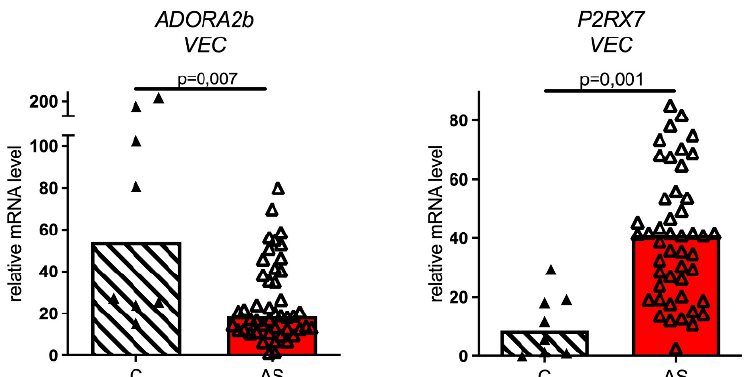
Figure 3. Expression levels of ADORA2b and P2RX7 in VEC. Relative mRNA levels in non-stenotic control cells (C) are compared with relative mRNA levels in stenotic cells (AS).